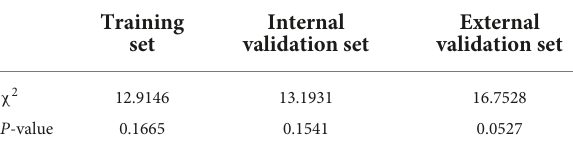
TABLE 6 Hosmer–Lemeshow